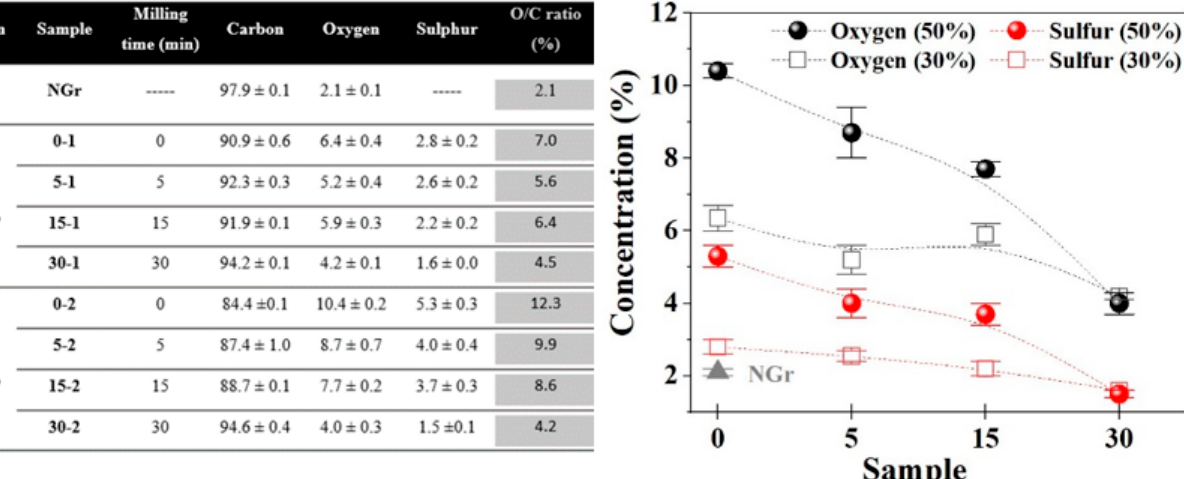
Figure 2. Summary chart with samples nomenclature, elemental results (in weight %), carbon/oxy- gen ratio, and their respective EDS plot. * The intercalated graphites (IGs) were prepared using two hydrogen peroxide solutions of different concentrations.